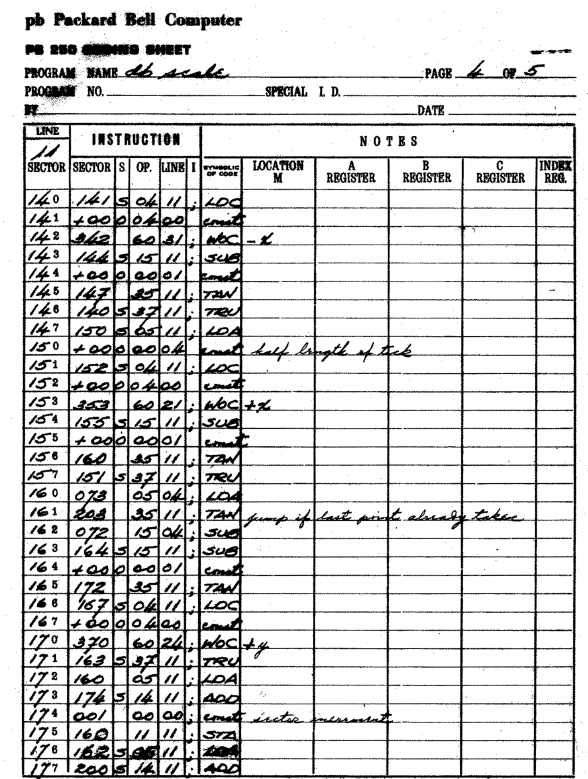
Figure 17. Sample page of a program for the Packard Bell PB250 computer. This computer had to be programmed using machine lan- guage (octal words), and no high-level language compiler was avail-